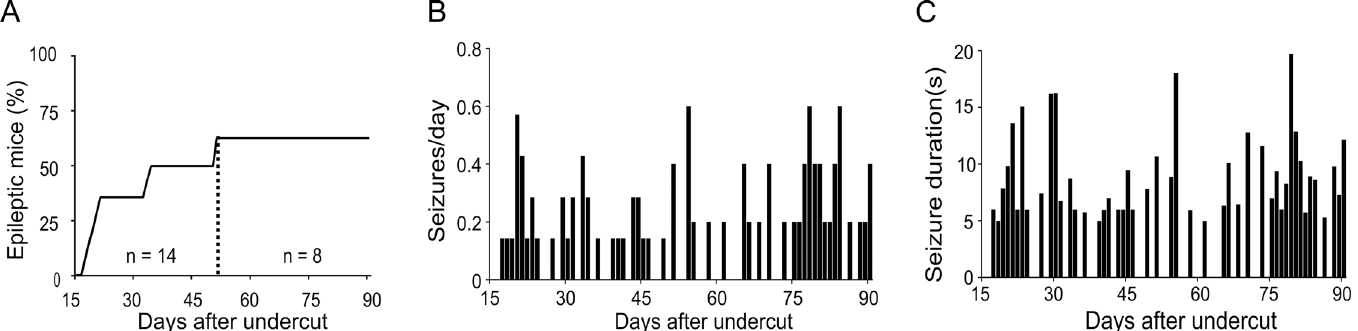
Fig 3. Characterization of spontaneous epileptic seizures in the undercut model. (A). Cumulative percentage of mice that developed posttraumatic epilepsy after undercut. In group I, 6 mice were recorded for 50 days; In group II, 8 mice were recorded for 90 days after injury. (B). Mean daily frequency of spontaneous seizure events per mouse during the recording period. There seems no significant change in the distribution of seizure frequency over time. (C). Mean duration of seizure events during the recording period. The seizure duration ranged between ~5 – 20 seconds.